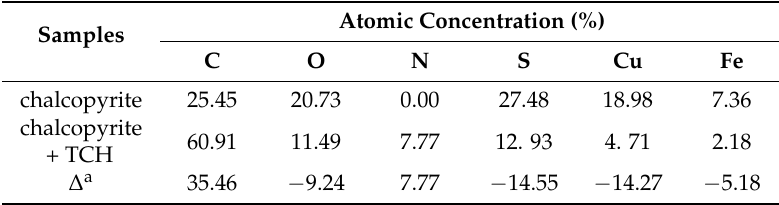
Table 1. Element contents of chalcopyrite with and without treatment.